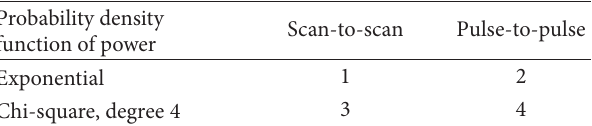
Table 1: Swerling